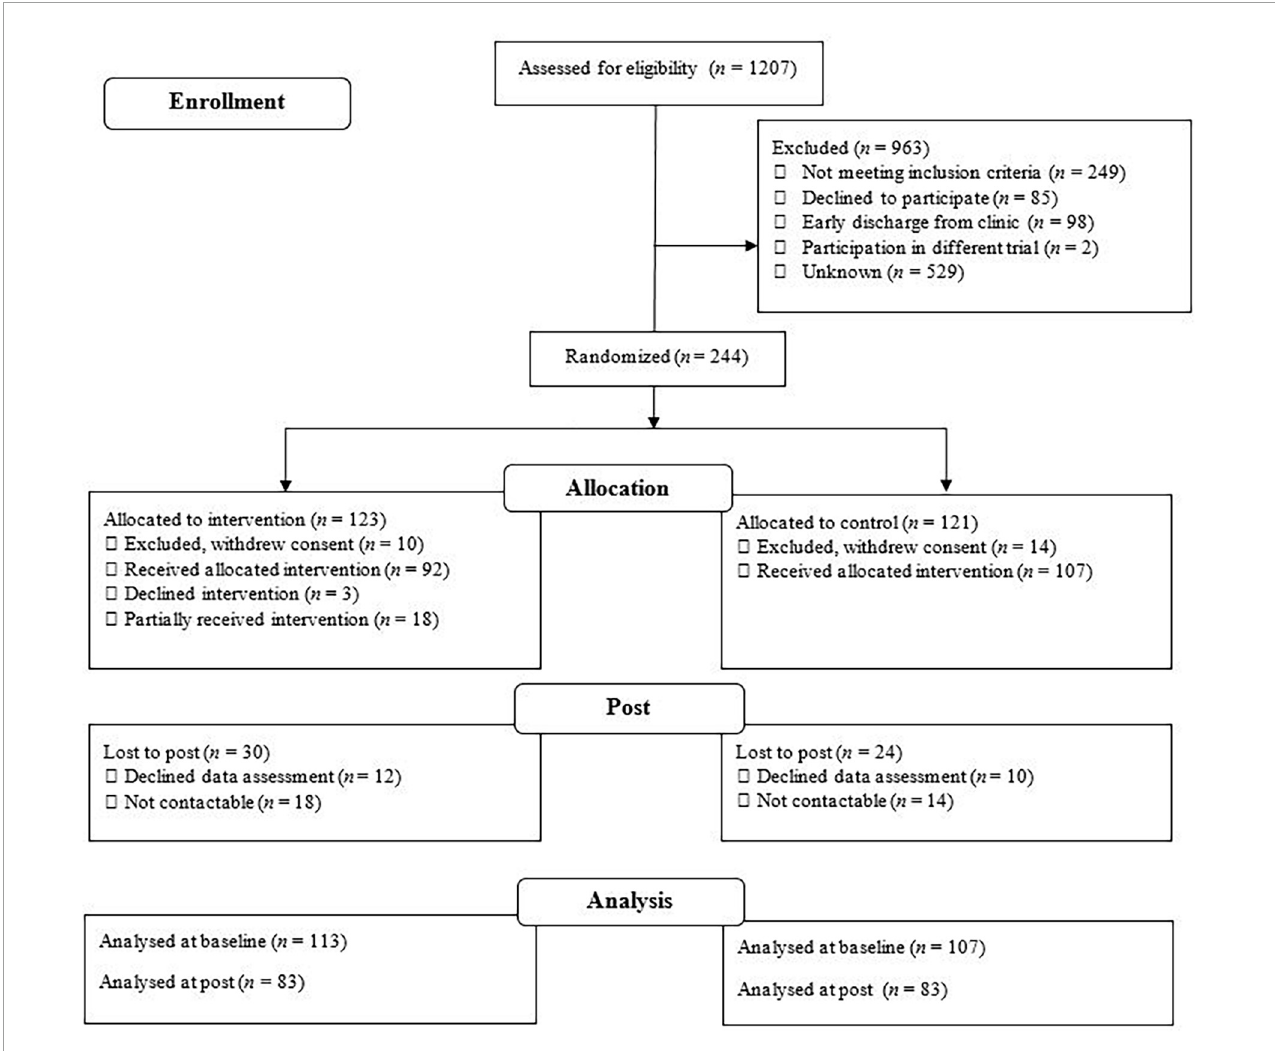
FIGURE2 Flow diagram according to CONSORT